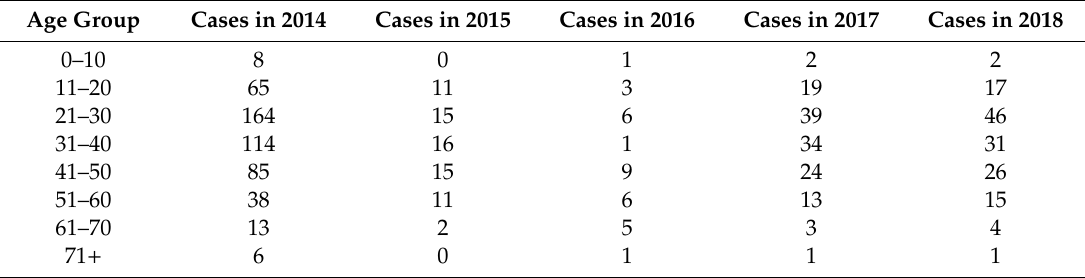
Table 3. Age group distribution of domestic imported dengue fever from 2014–2018. Age Group